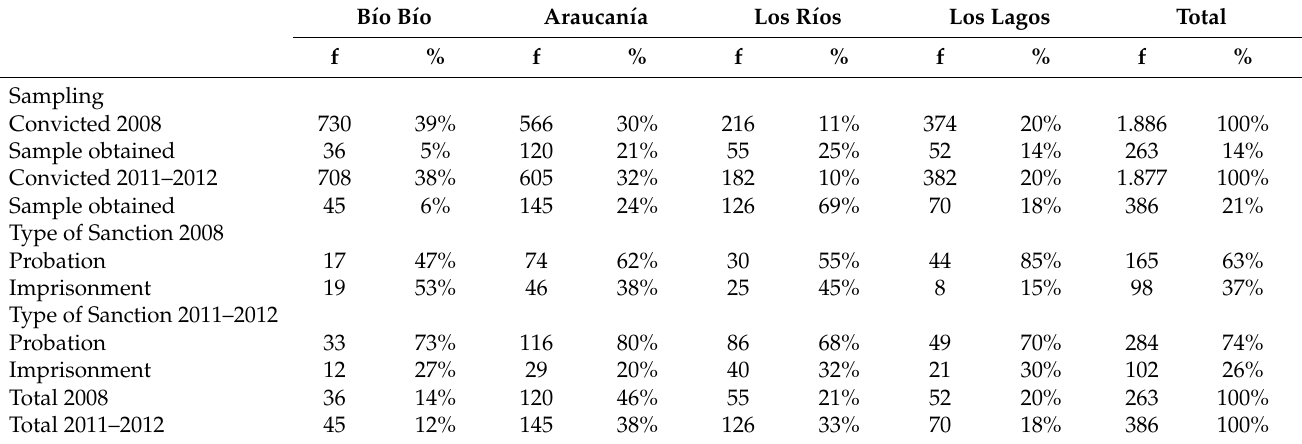
Table 1. Characterization of the samples by study, type of sentence, and region of